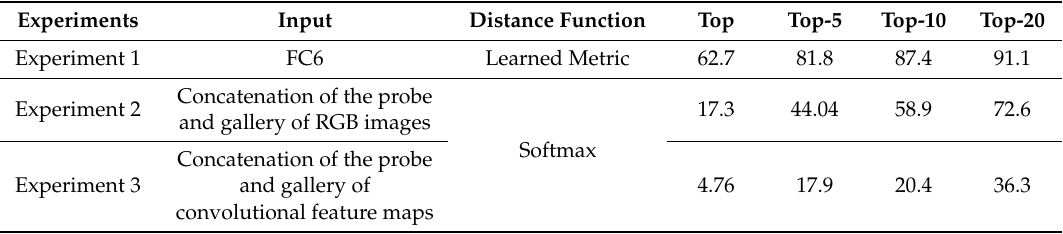
Table 5. List of the identification rate in Experiment 1, Experiment 2 and Experiment 3 for the PRW dataset.